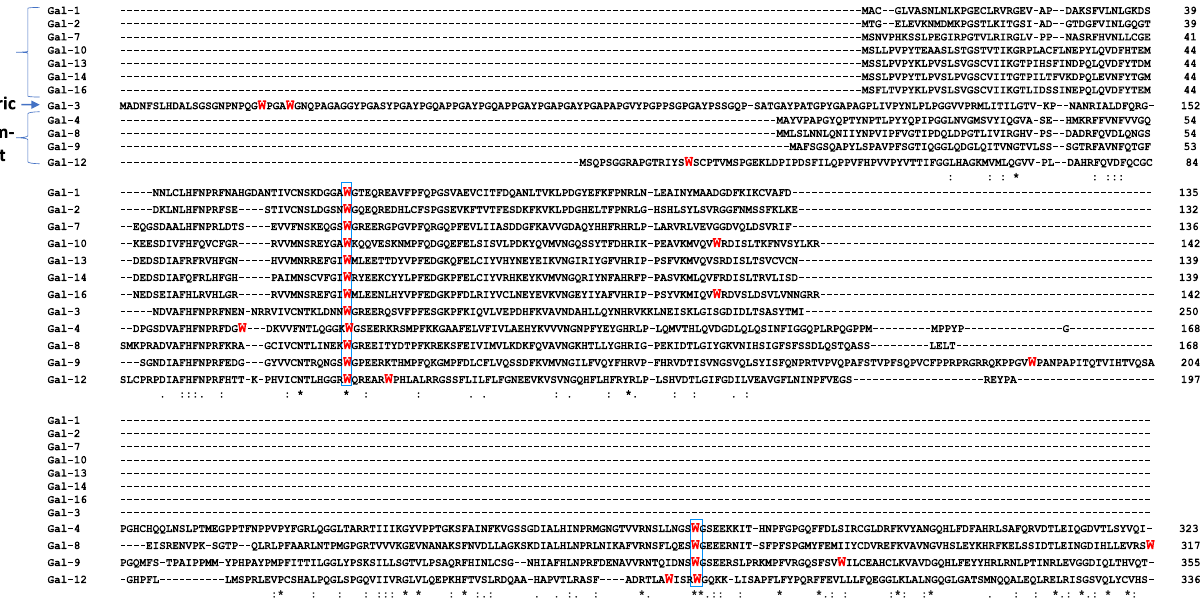
Figure 2. Multiple sequence alignment of members of human galectins. All the 12 known human galectins (Gal) are grouped on subtypes of prototypes: galectin-1 (UniProt code: P09382), galectin-2 (P05162), galectin-7 (P47929), galectin-10 (Q05315), galectin-13 (Q9UHV8), galectin-14 (Q8TCE9-1) and galectin-16 (A8MUM7); chimera type: galectin-3 (P17931) and tandem-repeat type: galectin-4 (P56470), galectin-8 (O00214-1), galectin-9 (O00182-1) and galectin-12 (Q96DT0-1). All tryptophan residues are coloured in red. Below the galectin sequence alignment is a key denoting conserved amino acid residues ( * ), conservative substitutions (:) and semi-conservative substitutions (.) within the Carbohydrate Recognition Domains (CRDs). The ubiquitous tryptophan residues in N- and C-terminal CRDs of all the galectin members are highlighted in blue